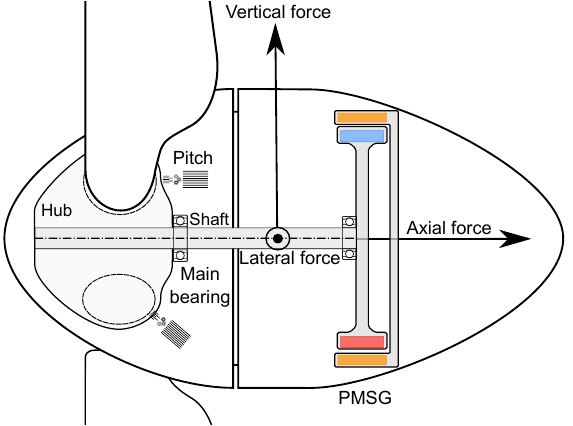
Figure 3. Main bearing